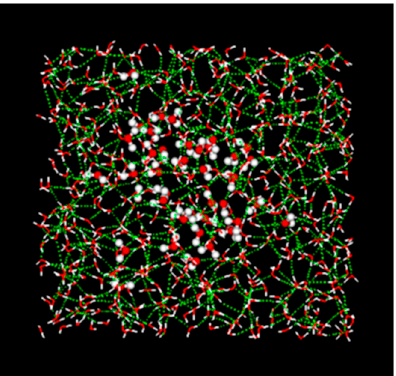
Figure 1. Hydrogen-bonding network (HBN) obtained from a molecular dynamics (MD) simulation. Forty water molecules around the center at the beginning are drawn by van der Walls model and surrounding molecules are shown by the wire model. The MD simulation was performed by Discovery Studio (Biovia) at Tokai University Computing Center.